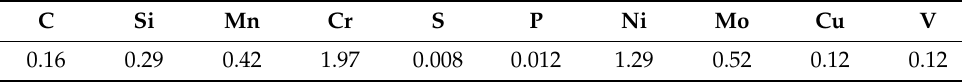
Table 1. 15Kh2NMFA base metal chemical composition (wt %) of the. C